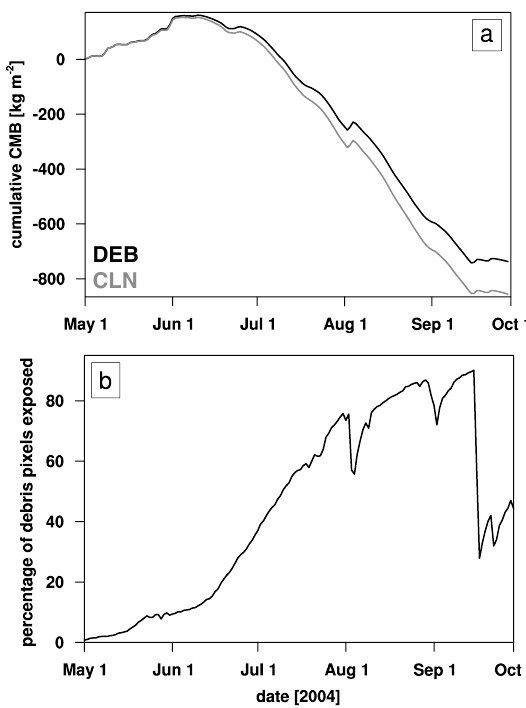
Figure 4. Time series of (a) basin-mean cumulative glacier CMB in kgm − 2 and (b) the daily maximum percentage of debris pixels that are exposed in DEB, for DEB (black curve) and CLN (gray) over the whole simulation period of 1 May to 1 October